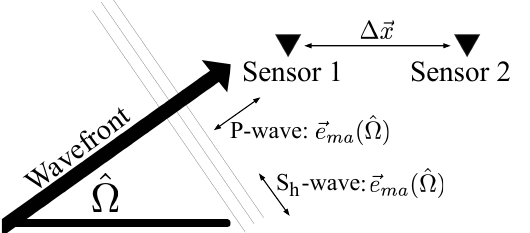
Figure 1. Plane waves from a possible source direction, ˆ Ω , arrive at two sensors shown in 2D. The plane wave is described for a given wave type, m , and polarization, A , with polarization vector (cid:126) e mA ( ˆ Ω ) . This is a simplified 2D example meant to illustrate the notation that we use in Section 2.1; in 3D, two angles are needed to describe the propagation direction, ˆ Ω